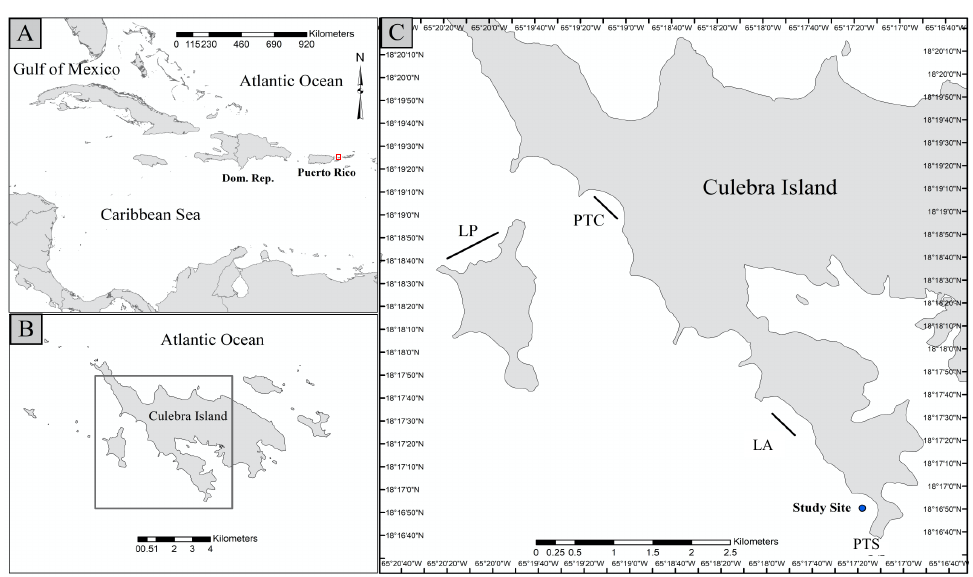
Figure 1. Map of Culebra illustrating its geographic location with respect to the Caribbean Region ( A , B ). The red frame in panel A indicates the location of Culebra Island, and sites of fragment collection and location of the coral farms ( C ). Collection sites: Luis Peña (LP), La Ahogá (LA), and Punta Tamarindo Chico (PTC); farming locations: Punta Soldado (PTS). Lines at collection sites represent the distance traveled during the fragment collections.